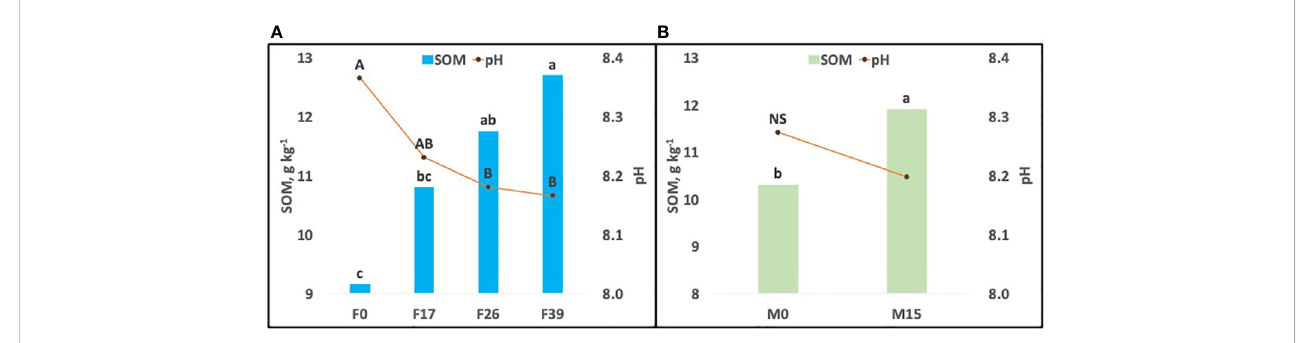
FIGURE 4 Postharvest soil pH and soil organic matter (SOM) as affected by P application from fertilizer (F) and/or farmyard manure (FYM). As the F × FYM interaction was not signi fi cant, the fertilizer graph (A) was averaged across FYM rates, and the FYM graph (B) was averaged across fertilizer rates. Fertilizer was applied at 0, 17, 26, or 39 kg P ha − 1 , and FYM was applied at 0 or 10 T ha − 1 with 0 or 15 kg P ha − 1 , respectively (FYM = 0.15% P). Treatment means with different letters are signi fi cantly different at p< 0.05. Data are shown as means ± SD ( n = 3).